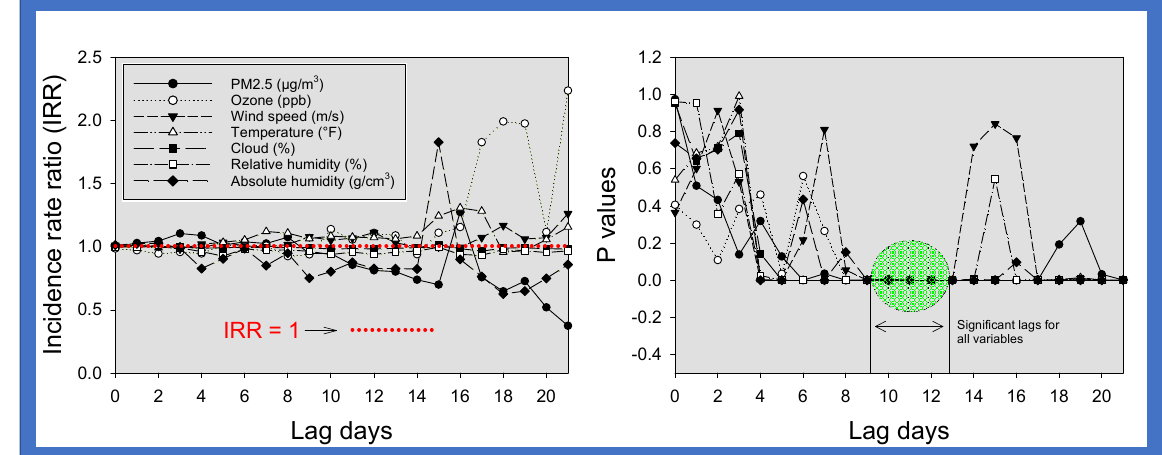
Figure 1. Changes in incidence rate ratios (IRRs) (left) and p -values (right) in relation to lags of days. Table 1. Actual incidence rate ratios (IRRs) and p numerical values for lags of days from 0 to 21 days. PM 2.5